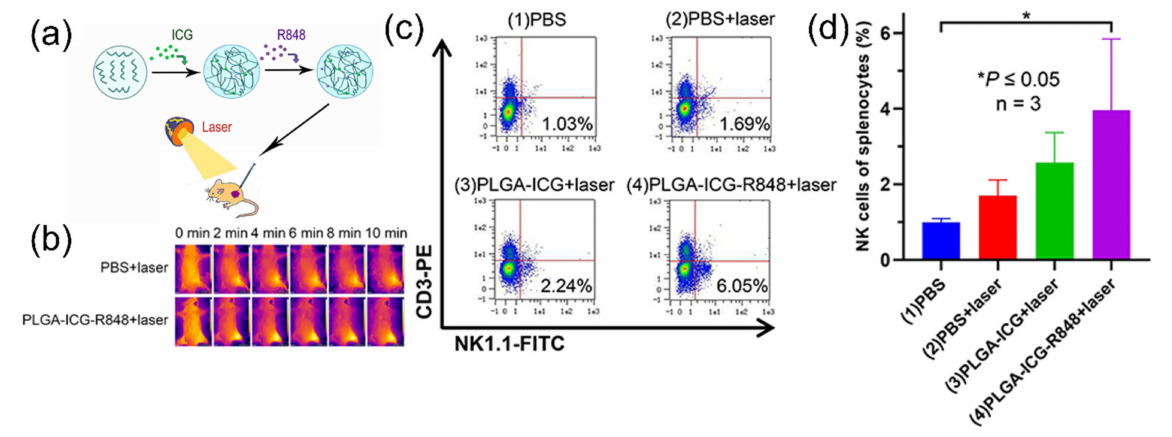
Figure 3. ( a ) Schematic diagram of PLGA-ICG nanoparticles with R848 for photothermal immunother- apy against RM9-tumor models; ( b ) thermal images of mice after the subcutaneous injection, followed by laser irradiation; ( c ) flow cytometry displaying the population of natural killer cells after PTT; ( d ) increased population of natural killer cells after treatment (* p < 0.05, n = 3). Figures are reproduced from ref. [62] with permission from Dove